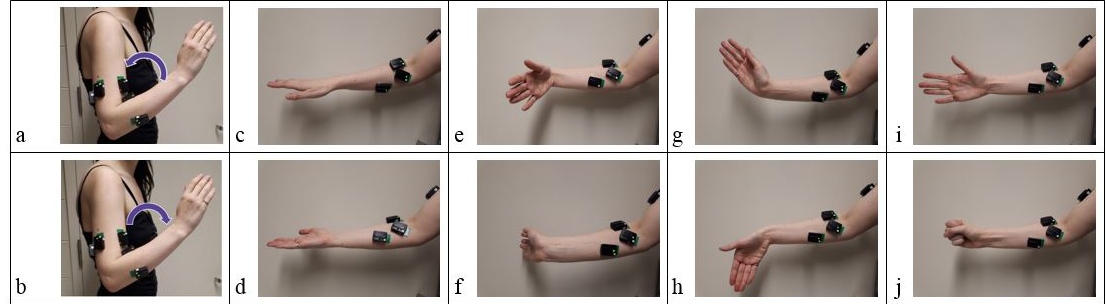
Figure 1. Ten upper-limb motions performed: ( a ) elbow flexion (EF), ( b ) elbow extension (EE), ( c ) forearm pronation (P), ( d ) forearm supination (S), ( e ) wrist flexion (WF), ( f ) wrist extension (WE), ( g ) ulnar deviation (UD), ( h ) radial deviation (RD), ( i ) hand open (HO), and ( j ) hand close